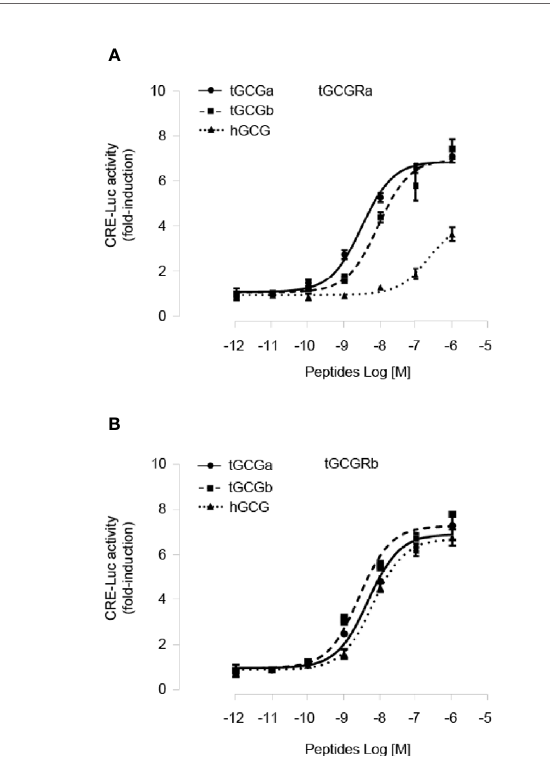
FIGURE 3 | Functional characterization of tilapia GCGRa and GCGRb expressed in HEK293 cells. HEK293 cells with stable expression of tilapia (A) GCGRa or (B) GCGRb were transfected with CRE-Luc reporter targeting the cAMP pathways and treated for 24 h with increasing doses of the tilapia GCGa, GCGb, and human GCG, respectively. In these experiments, the cotransfection of pTK-RL was used as the internal control, and the data were transformed as a ratio of Renilla luciferase activity in the same sample (as Luc Ratio). All results are expressed as the mean ± SEM (N = 3).